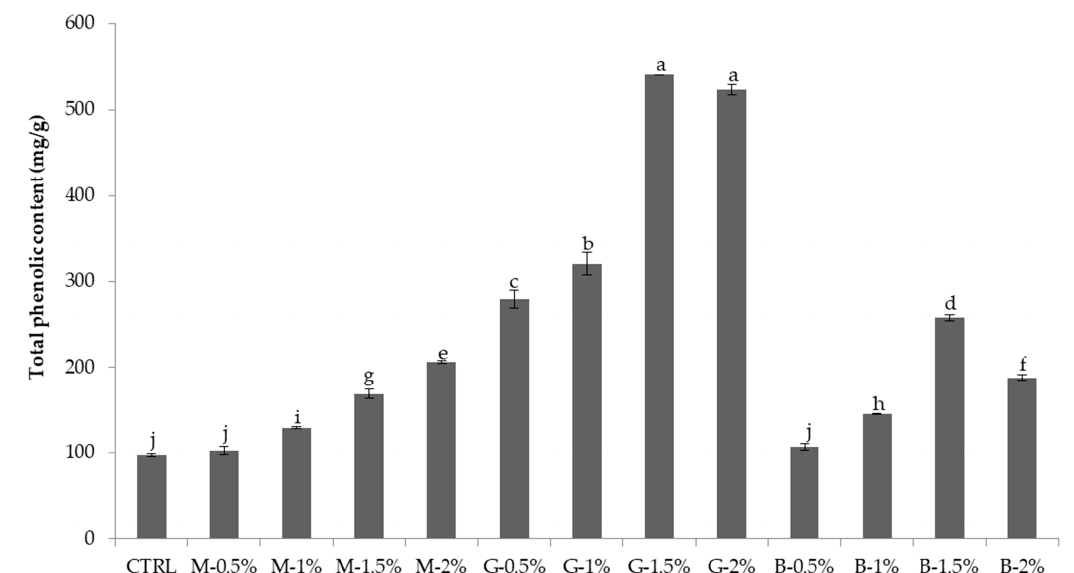
Figure 2. Antioxidant activity (% of control) of dry tea noodles with different tea extracts. CTRL: noodles without tea powder; M-0.5%, M-1.0%, M-1.5%, and M-2.0%: noodles with additional 0.5%, 1.0%, 1.5%, and 2.0% matcha tea powder, respectively; G-0.5%, G-1.0%, G-1.5%, and G-2.0%: noodles with additional 0.5%, 1.0%, 1.5%, and 2.0% green tea powder, respectively; B-0.5%, B-1.0%, B-1.5%, and B-2.0%: noodles with additional 0.5%, 1.0%, 1.5%, and 2.0% black tea powder, respectively; All addition levels were on a flour basis. The values followed by different letters were significantly different ( p < 0.05).